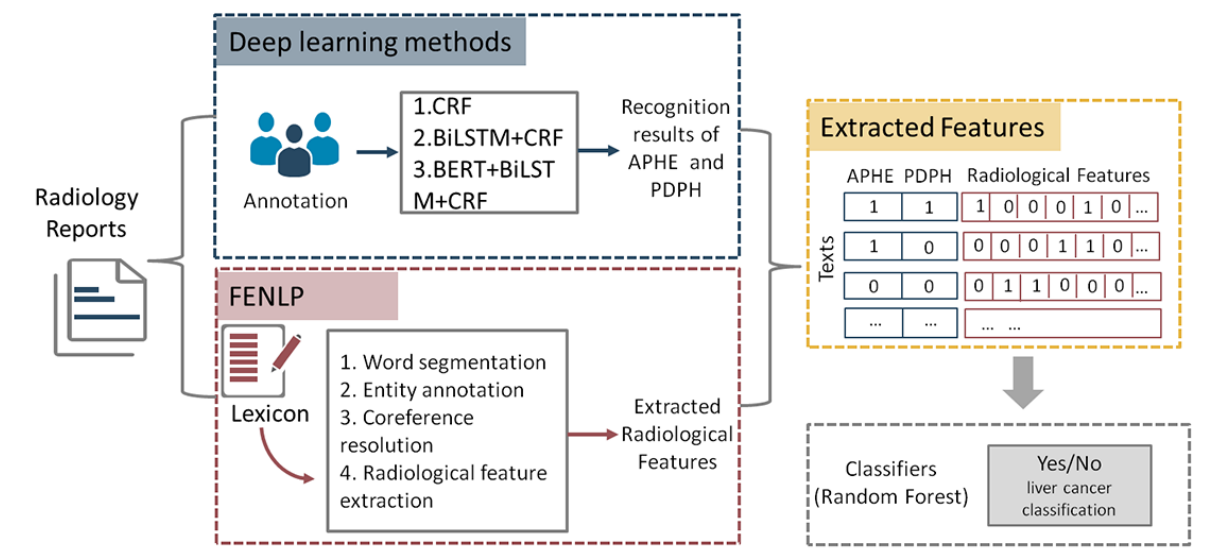
Figure 1. The workflow of this research. Labels 0/1 represent the absence/presence of a certain feature. BERT: Bidirectional Encoder Representations from Transformers; BiLSTM: bidirectional long short-term memory; CRF: conditional random field; APHE: hyperintense enhancement in the arterial phase; PDPH: hypointense in the portal and delayed